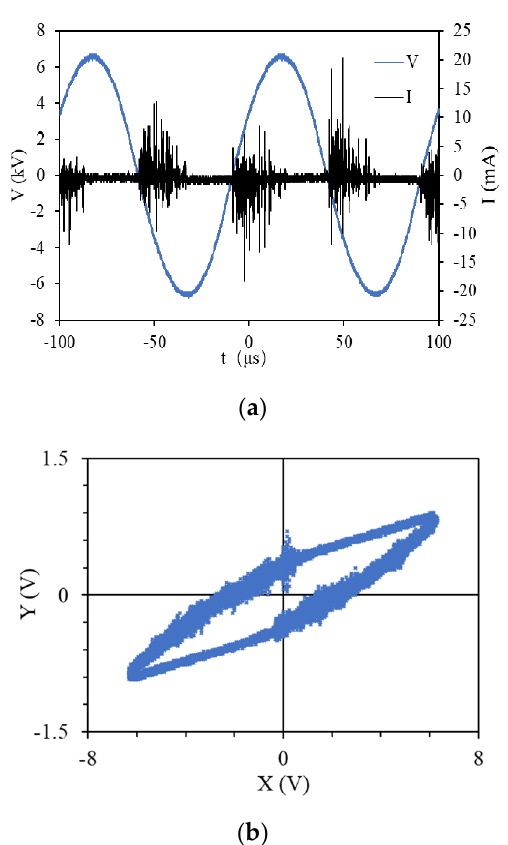
Figure 4. The current and voltage waveforms for the DBD reactor: ( a ) the voltage and current waveforms; ( b ) the Lissajous figure. waveforms; ( b ) the Lissajous